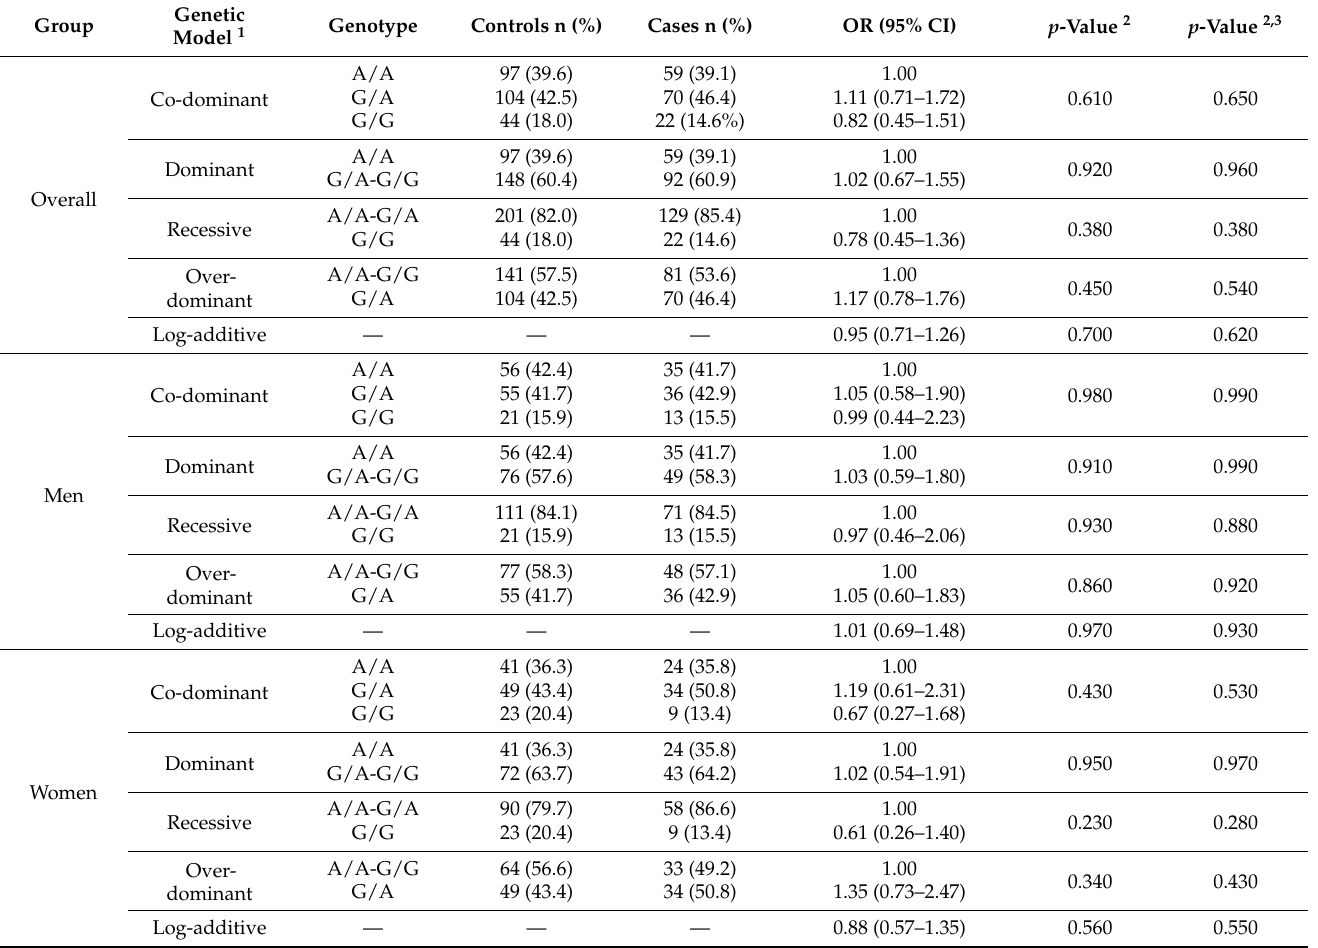
Table 2. Association analysis of rs2472493 polymorphism upstream of ABCA1 with primary open- angle